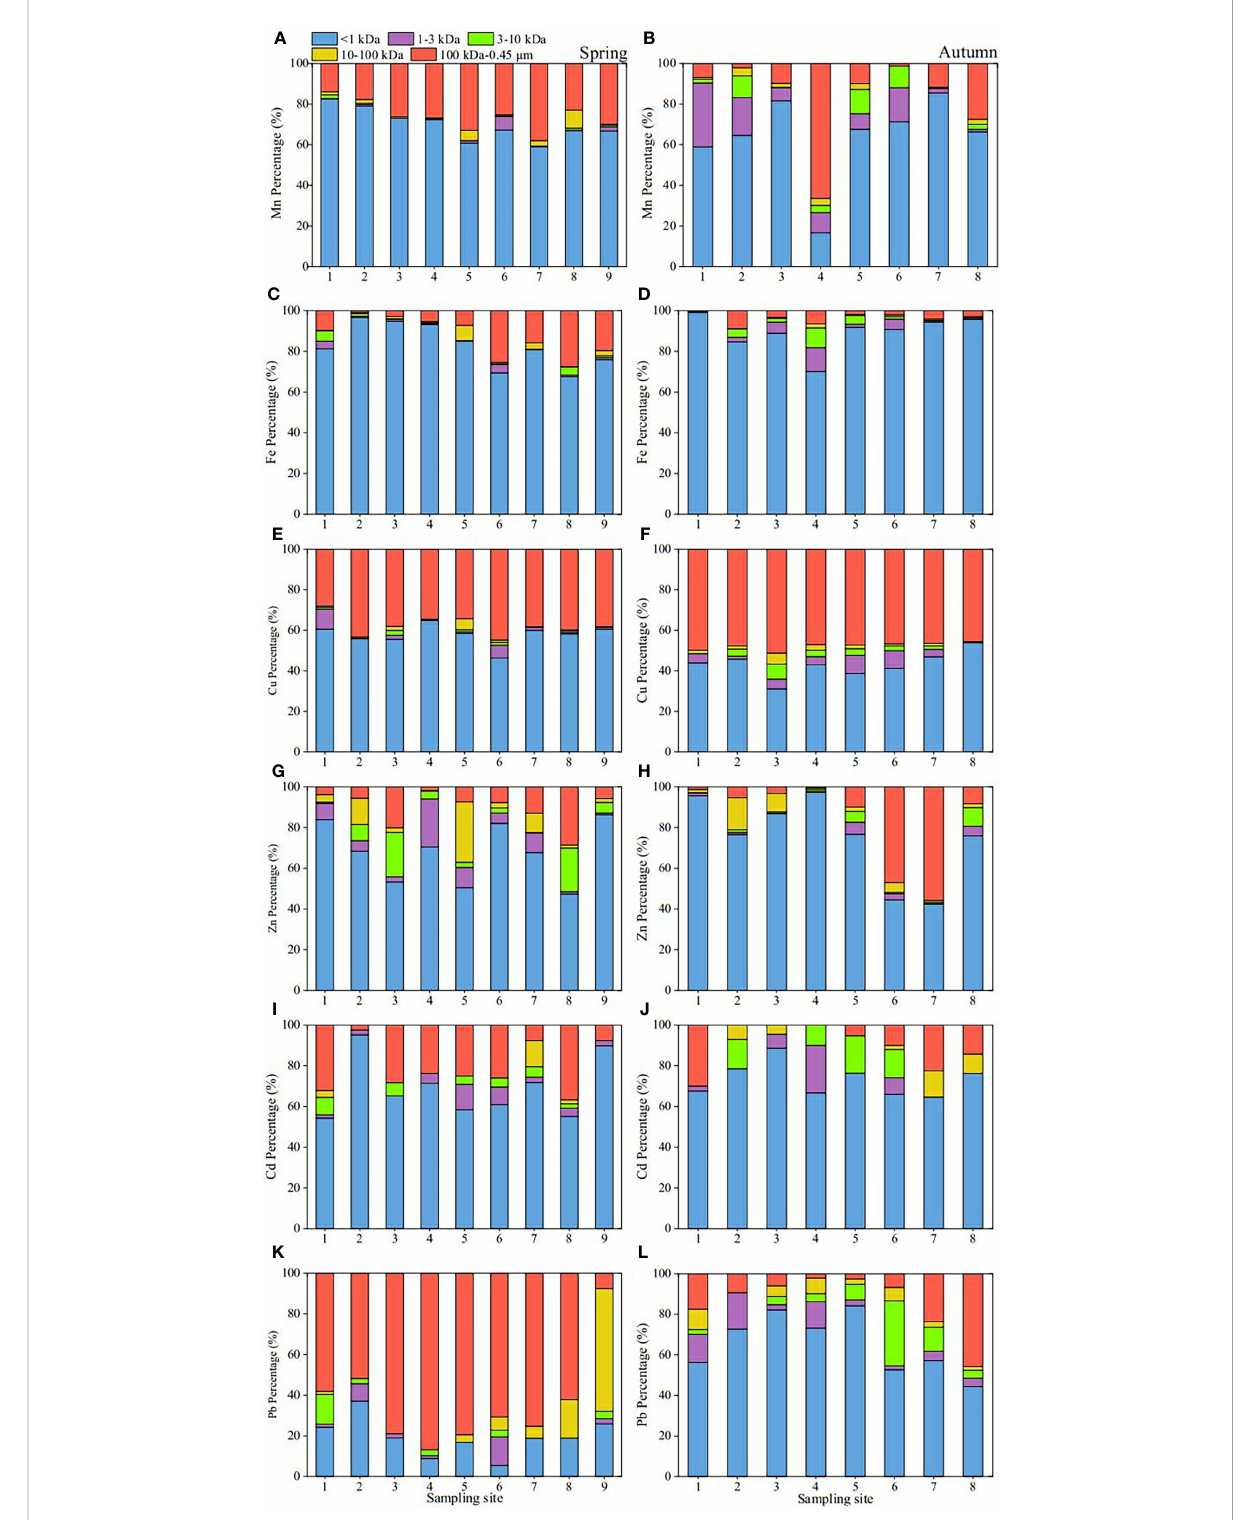
FIGURE 6 Percentage distribution of Mn, Fe, Cu, Zn, Cd and Pb at different sites in surface waters of the Yellow River Estuary in spring (A, C, E, G, I and K) ; autumn (B, D, F, H, J and L)